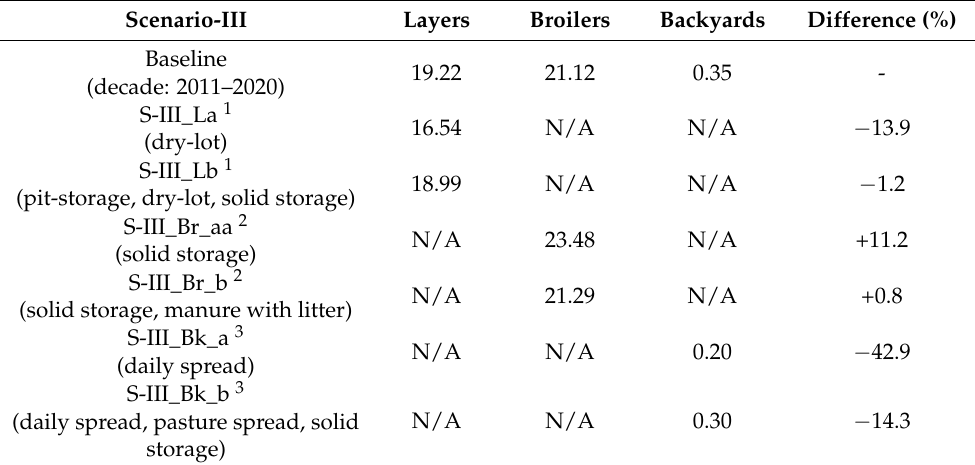
Table 3. Results of mitigation scenario-III (changes in manure management system) in total GHG emissions ( × 10 9 kg CO 2 -eq/year) at the national